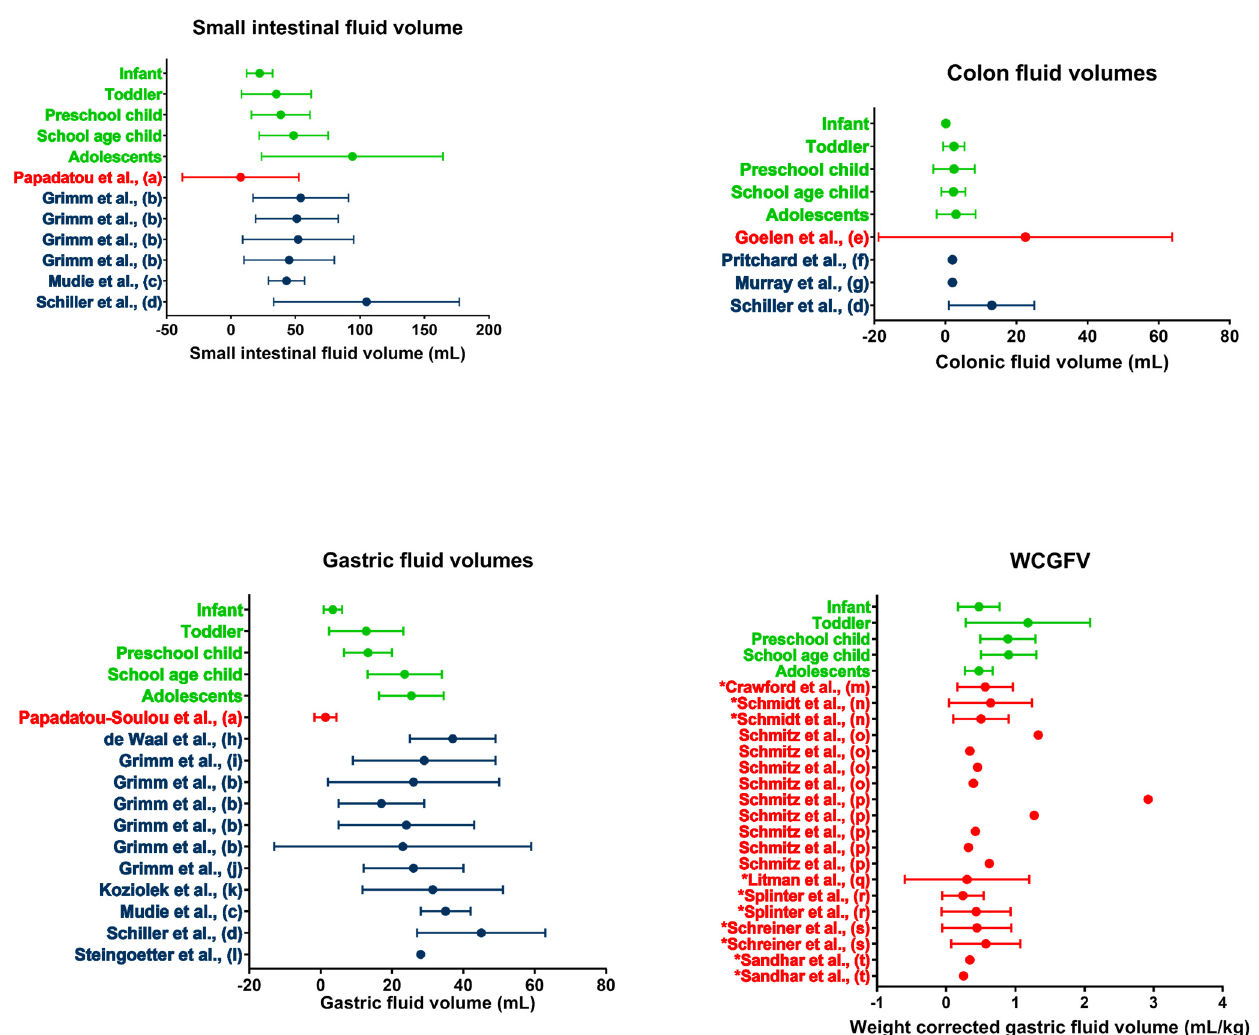
Figure 5. Literature comparison for SI, colon, gastric, and WCGV. Dots indicate average volumes; error bars indicate standard deviations. Data obtained in the present study (green) are compared to data from other studies on children (red) or adults (blue). WCGV measured from fluid aspirations are indicated by a * in front of the reference; other WCGVs are measured using MRI. (a [14], b [20], c [17], d [31], e [13], f [32], g [33], h [22], i [21], j [35], k [26], l [36], m [37], n [38], o [39], p [40], q [41], r [42], s [43], t [44]).